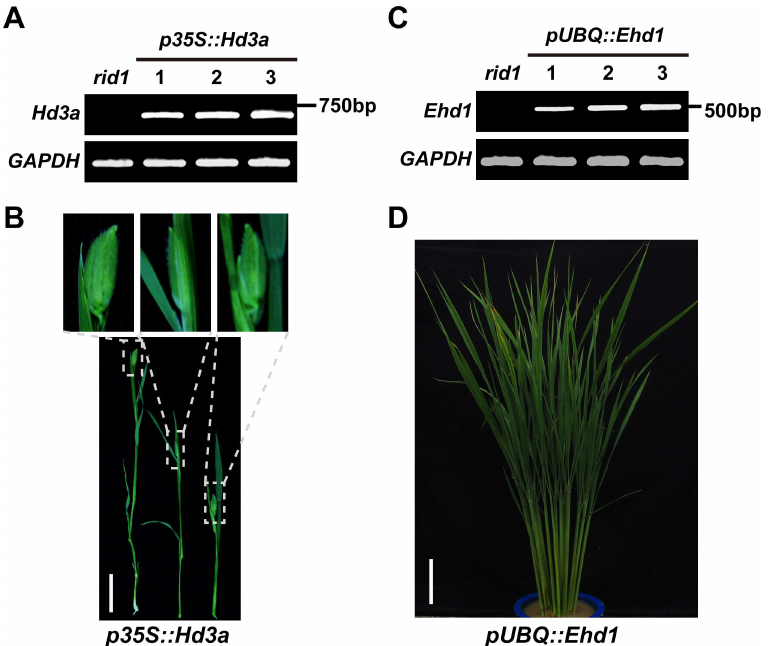
Fig 9. Overexpressing of Hd3a and Ehd1 in rid1 plants. (A) Expression analysesof Hd3a in p35S :: Hd3a transgenic plants. Three independenttransformed lines were analyzed. rid1 served as the negativecontrol. (B) Hd3a , driven by the CaMV 35S promoter( p35S :: Hd3a ), rescued the never-floweringphenotype of rid1 and headingat seedlingstage (T0 plants, n = 40). Top insets show magnifications of the paniclessurrounded by dashed lines. Scale bar, 2 cm. (C) Expression analysesof Ehd1 in pUBQ :: Ehd1 transgenic plants. Three independent transformed lines were analyzed. rid1 was used as a negativecontrol. (D) Overexpression of Ehd1 in rid1 ( pUBQ :: Ehd1 ) could not reverse the never-flowering phenotype of rid1 (T0 plants, n = 80). All plants were grown under natural-long-day conditions. Scale bar, 15 cm.